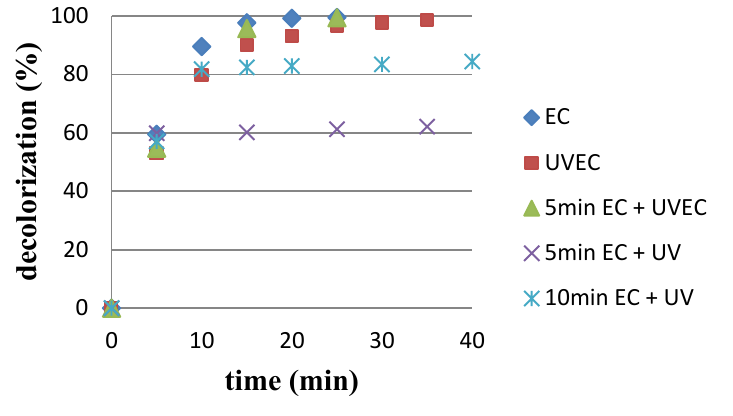
Figure 2. PN effluent decolorization evolution with different combination of electrochemical (10 A) and photo-electrochemical treatments.